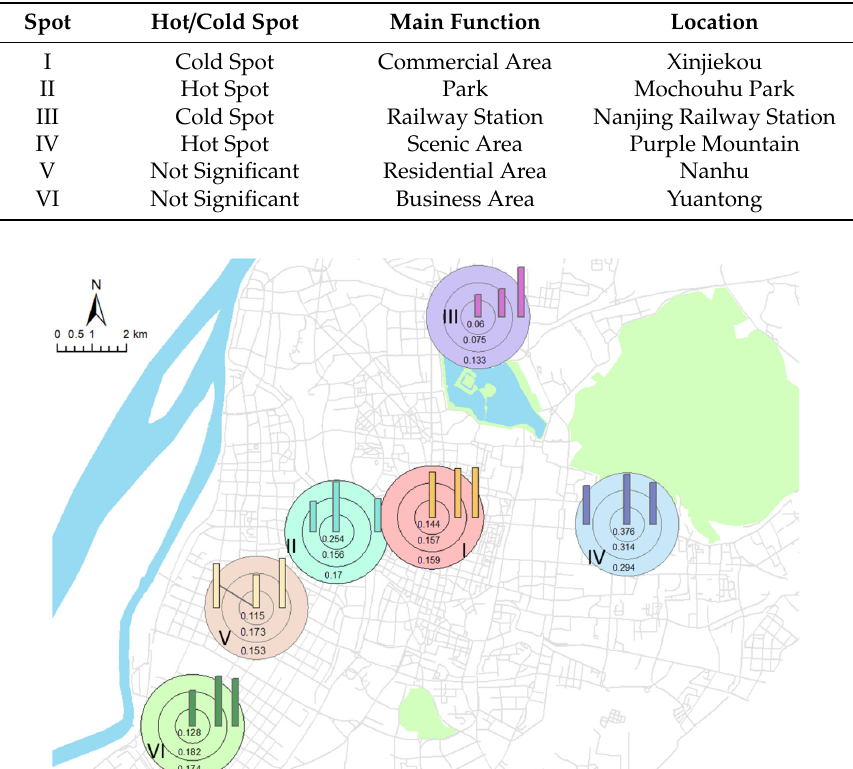
Figure 8. GVI distribution pattern around six typical spots in the Nanjing urban area. I, II, III, IV, V and VI represent the commercial area, park, railway station, scenic area, high-density residential area and business area. Three-ring buffers were constructed every 500 m from each spot, and the average GVI values are labeled on the rings and shown by the bars.